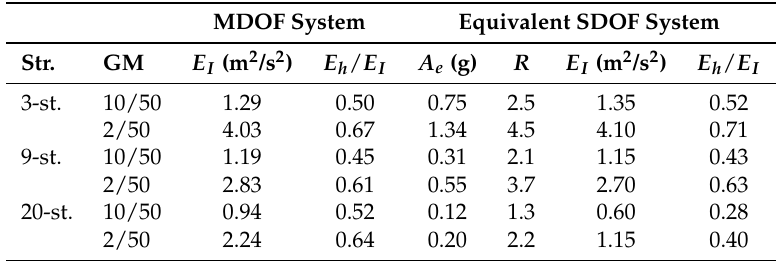
Table 3. Total Energy Demands on MDOF and Equivalent SDOF